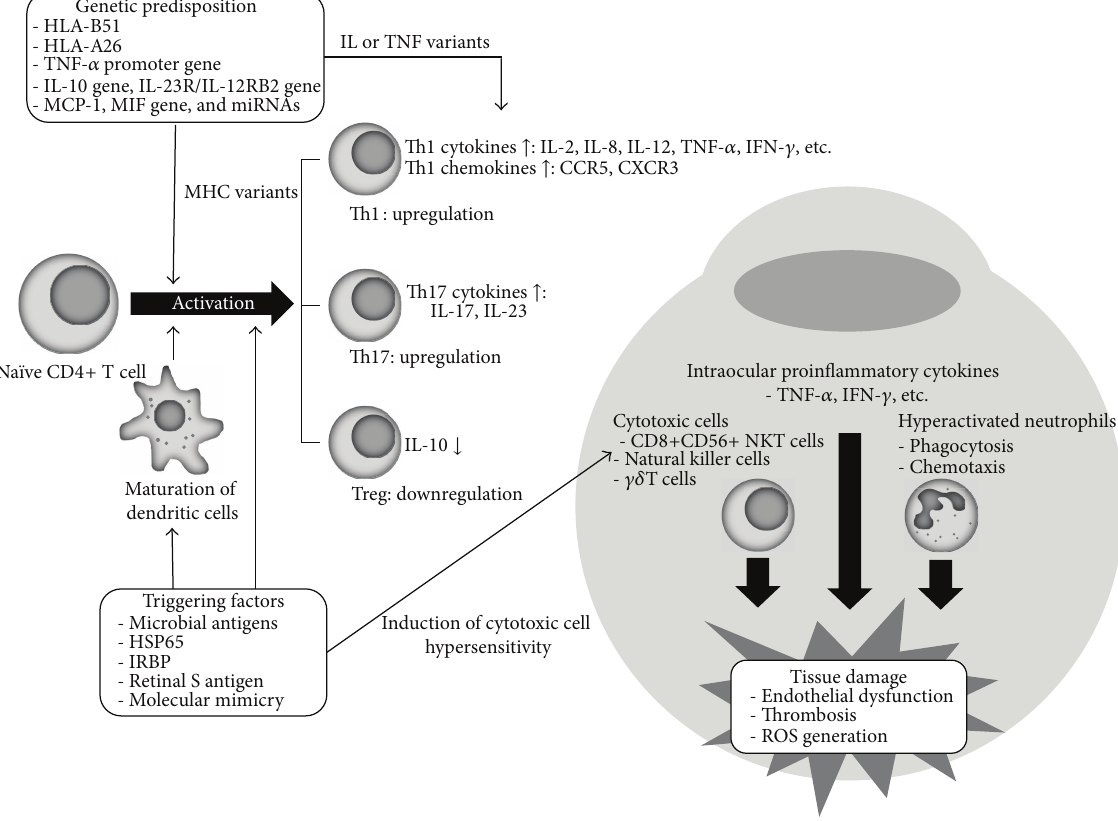
Figure 1: Immunopathogenesis of Behc¸et’s uveitis. Hypersensitivity of T cells and cytotoxic cells to various antigens and predisposing genetic factors play a crucial role in the pathogenesis of Behc¸et’s uveitis. The high maturation profiles of dendritic cells can contribute to the perpetuation of the inflammation, and chemokines and cytokines are mediators that can generate and augment the immune response in inflammatory